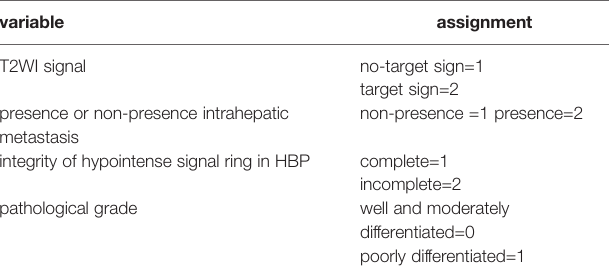
TABLE 3 | Factor assignment.